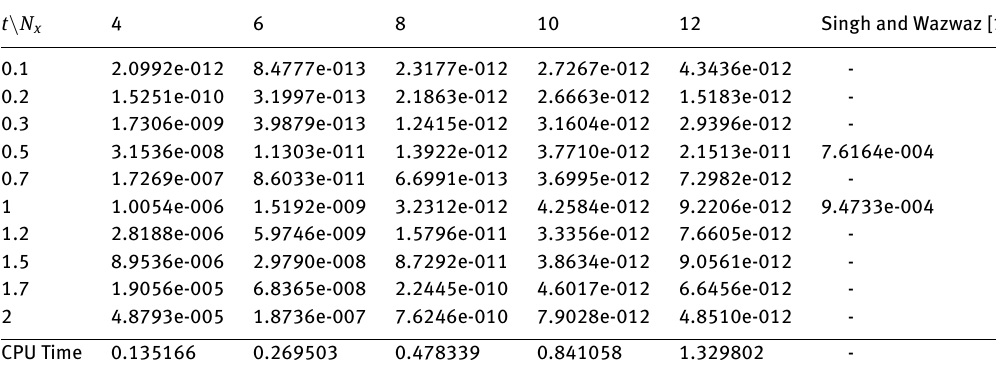
Table 5: Maximum errors E N for example 4 using N t = 10, m = s = 3 and k = 1, p = 2